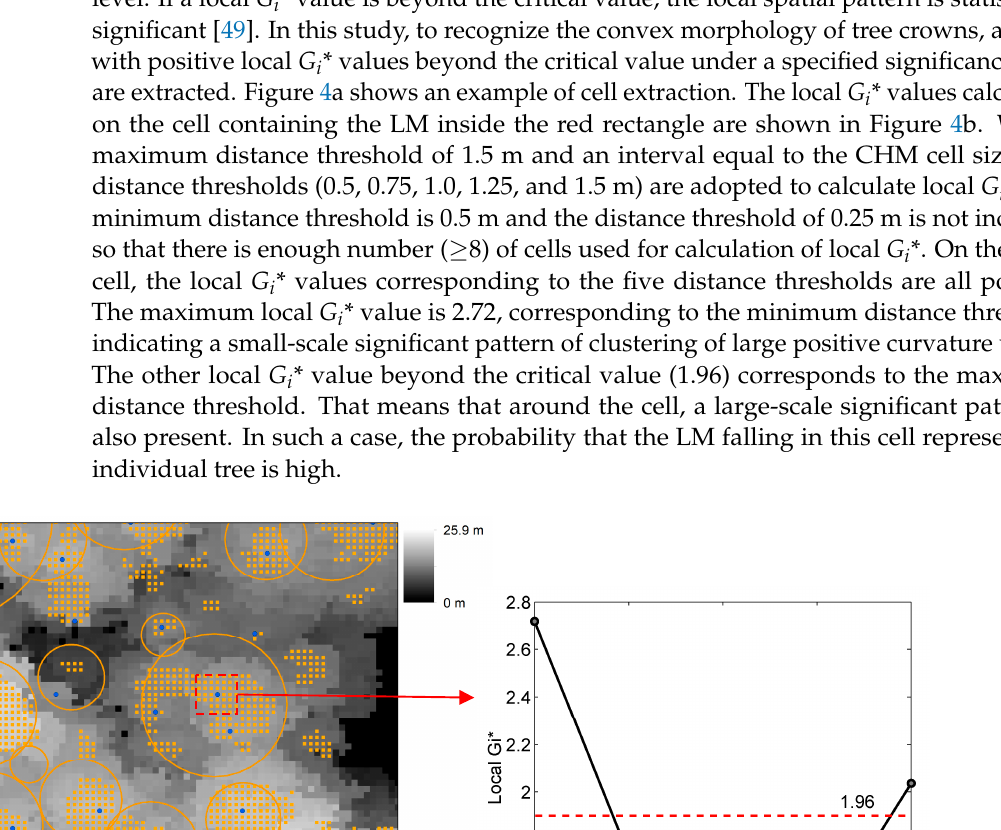
7 of 26 Figure 3. Extraction of cells with positive profile curvature values.